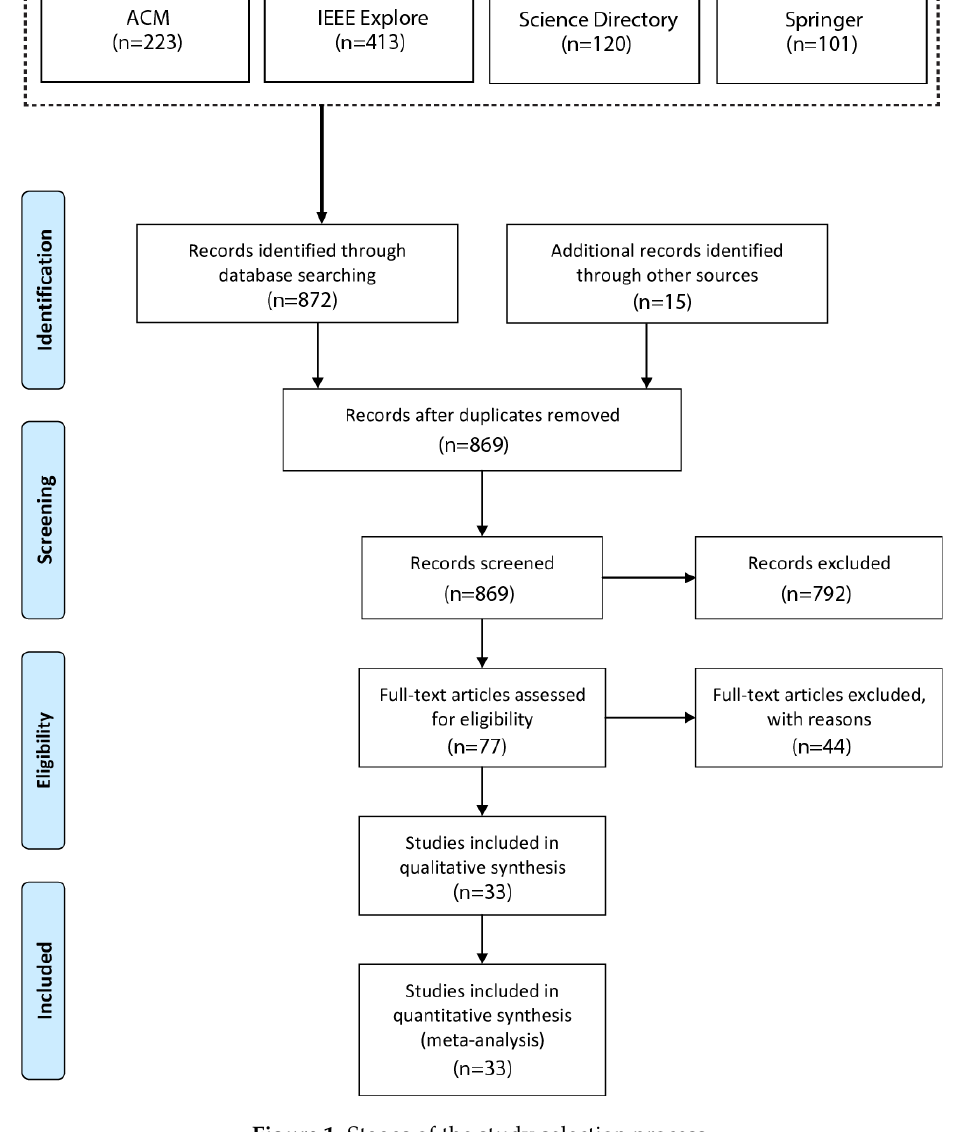
Figure 1. Stages of the study selection